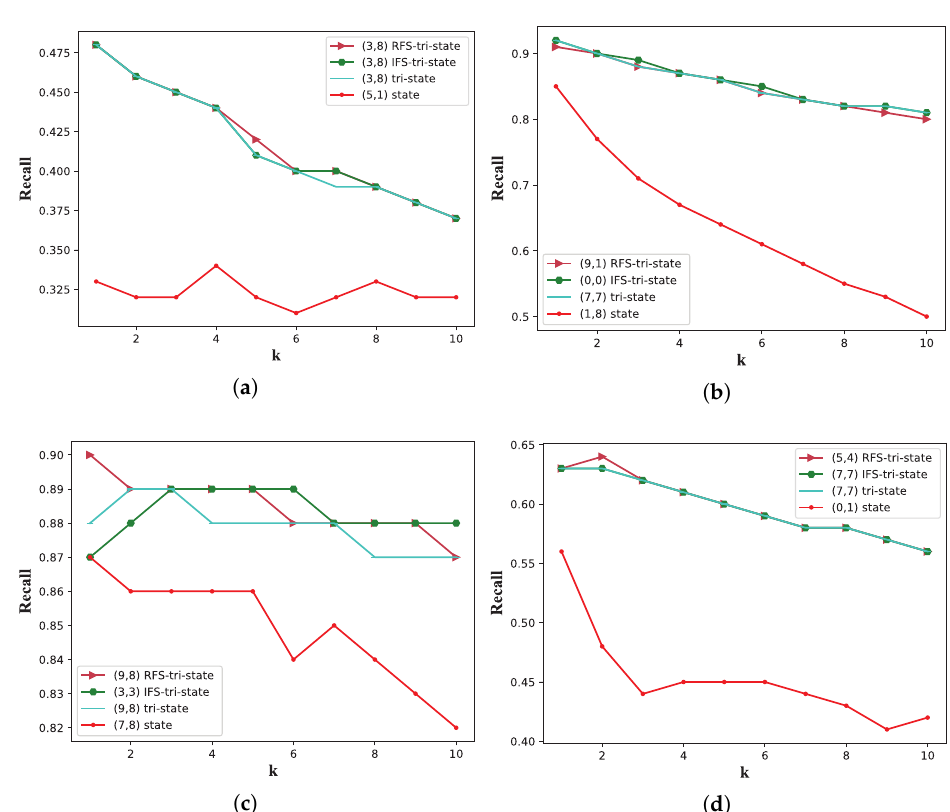
Figure 5. The recalls of four state prediction strategies. ( a ) Dataset I. ( b ) Dataset II. ( c ) Dataset III. ( d ) Dataset